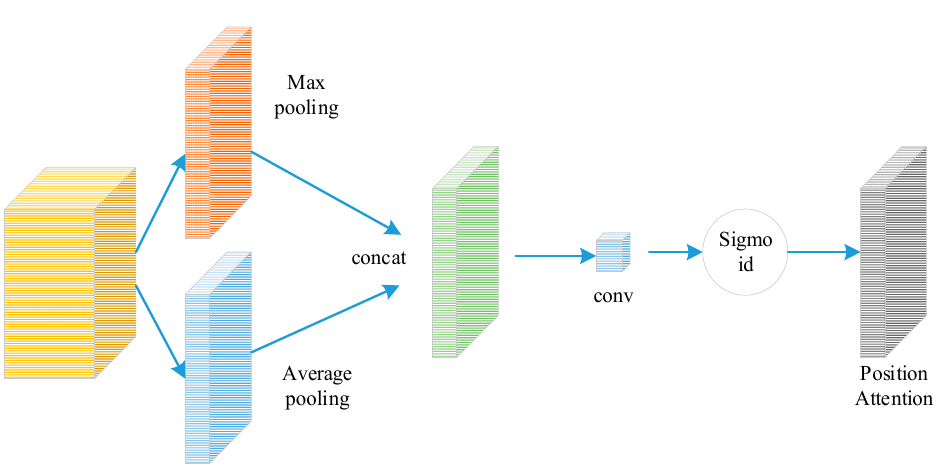
Figure 8. Position attention module.